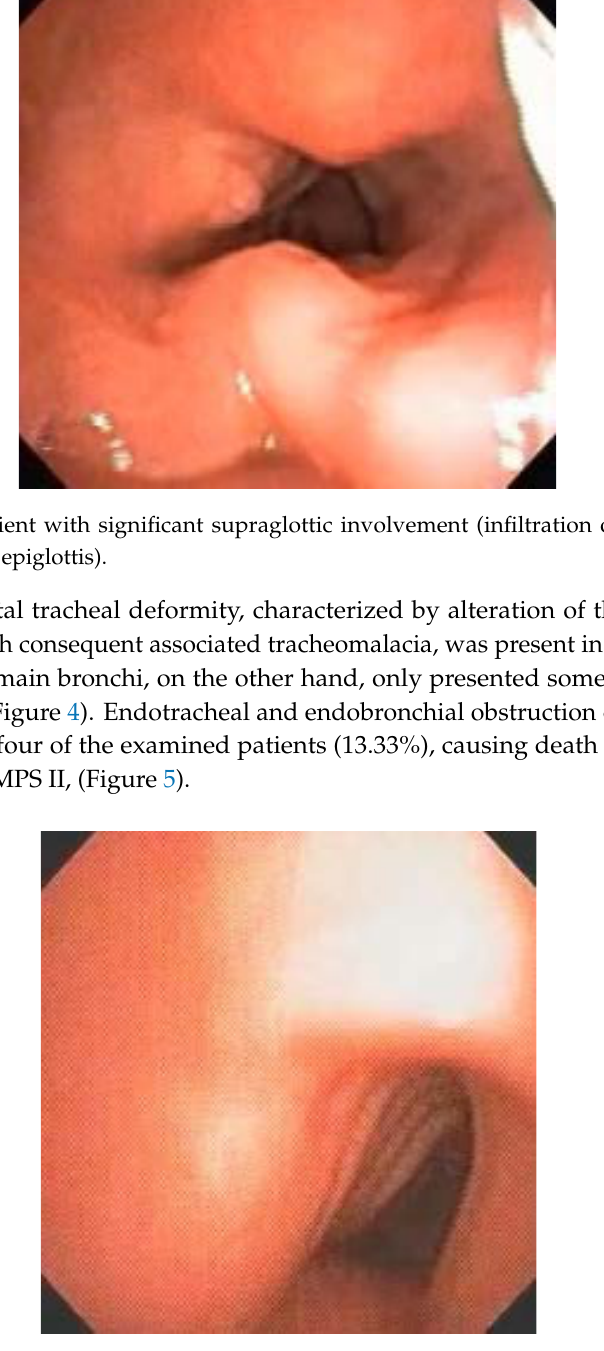
Figure 5. Significant glycosaminoglycan (GAG) infiltration in a MPS II patient (infiltration and architectural distortion of the distal trachea and right main bronchus). After reassessment of all examinations by three endoscopists in our group, the patients were classified according to LTBD (sum of laryngeal disease and tracheobronchial disease): four patients (13.33%) did not present any abnormality in the endoscopic exam (all with MPS VI); nine patients (30%) had mild to moderate disease; 12 patients (40%) had moderate to severe disease; and finally five patients (16.67%) had severe disease (three with neuronopathic MPS II and 2 with MPS VI) (Table 2). Table 2. Summary of the main endoscopic findings of laryngotracheobronchial disease according to MPS type. MPS Type Endoscopic Laryngeal Disease Tracheobronchial Endoscopic Disease MPS I (6 patients)